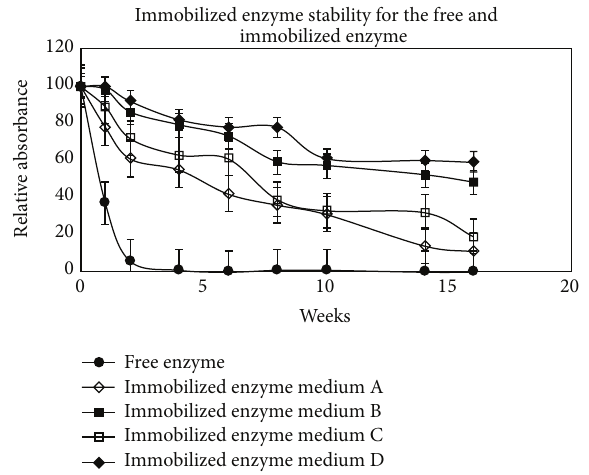
Figure 5: Operational stability of immobilized urease on different